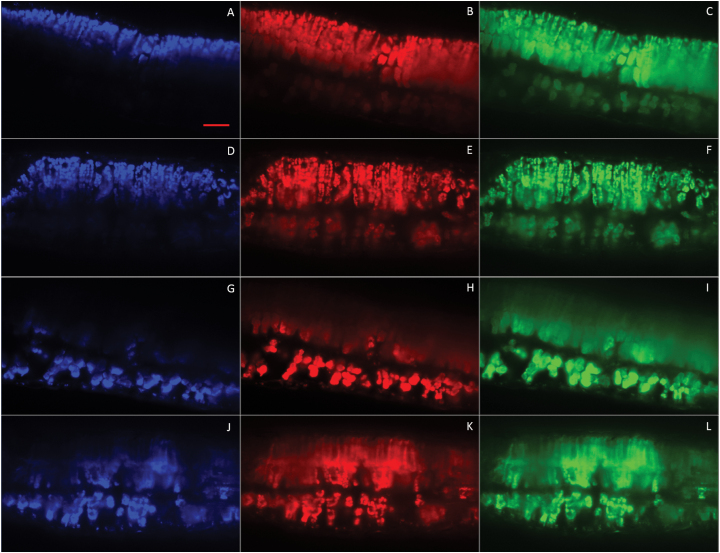
Fluorescence profiles of chamber-grown WT (ABCGHI) and Y11y11 (DEFJKL) cross-sections within a z-stack when illuminated from the adaxial (A–F) or abaxial (G–L) surface with blue (445nm; A, D, G, J), red (638nm; B, E, H, K), and green (561nm; C, F, I, L) lasers using light sheet microscopy. Fluorescence was falsely colored to represent the illumination wavelength. Scale bar in (A) = 50 µm. Pixel size = 0.23 µm.